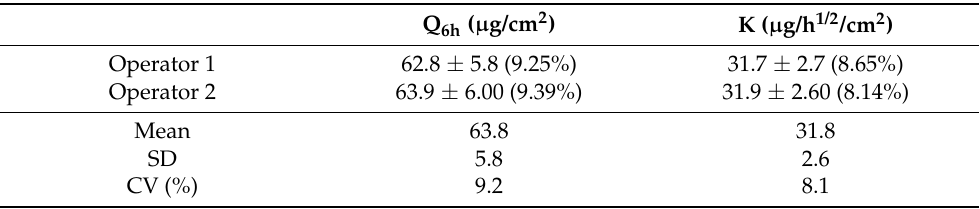
Table 4. Intermediate precision of the IVRT study. Table shows mean value, and values in brackets show the relative standard deviation (CV%) for the released amount of capsaicin at 6 h (Q 6h ) and release constant